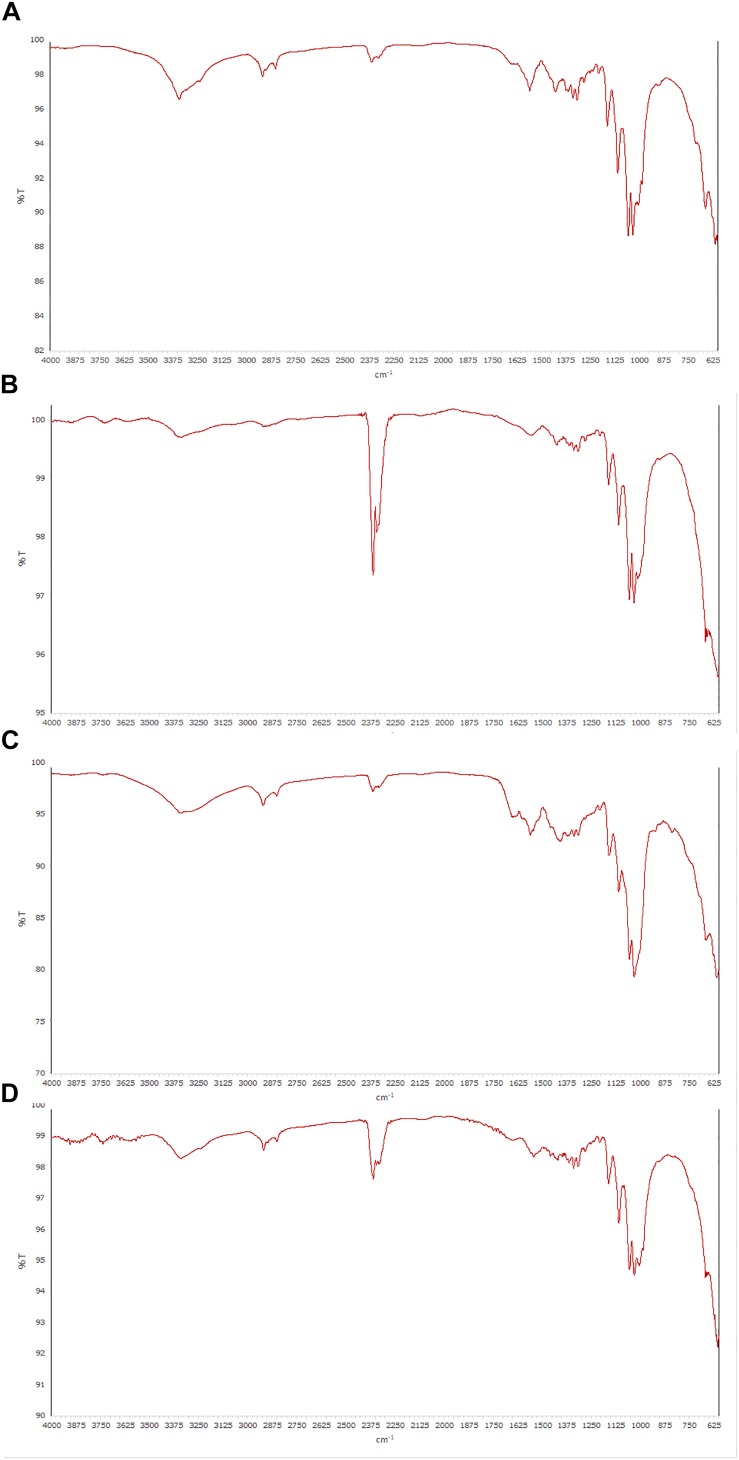
ATR-FT-IR spectra of cellulose samples produced from different strains. (A,B) GVP and GDP isolates of K. rhaeticus LMG 22126T strain, respectively; (C) GSP isolate of K. swingsii LMG 22125T strain; (D)
K. xylinus LMG 1518 strain.